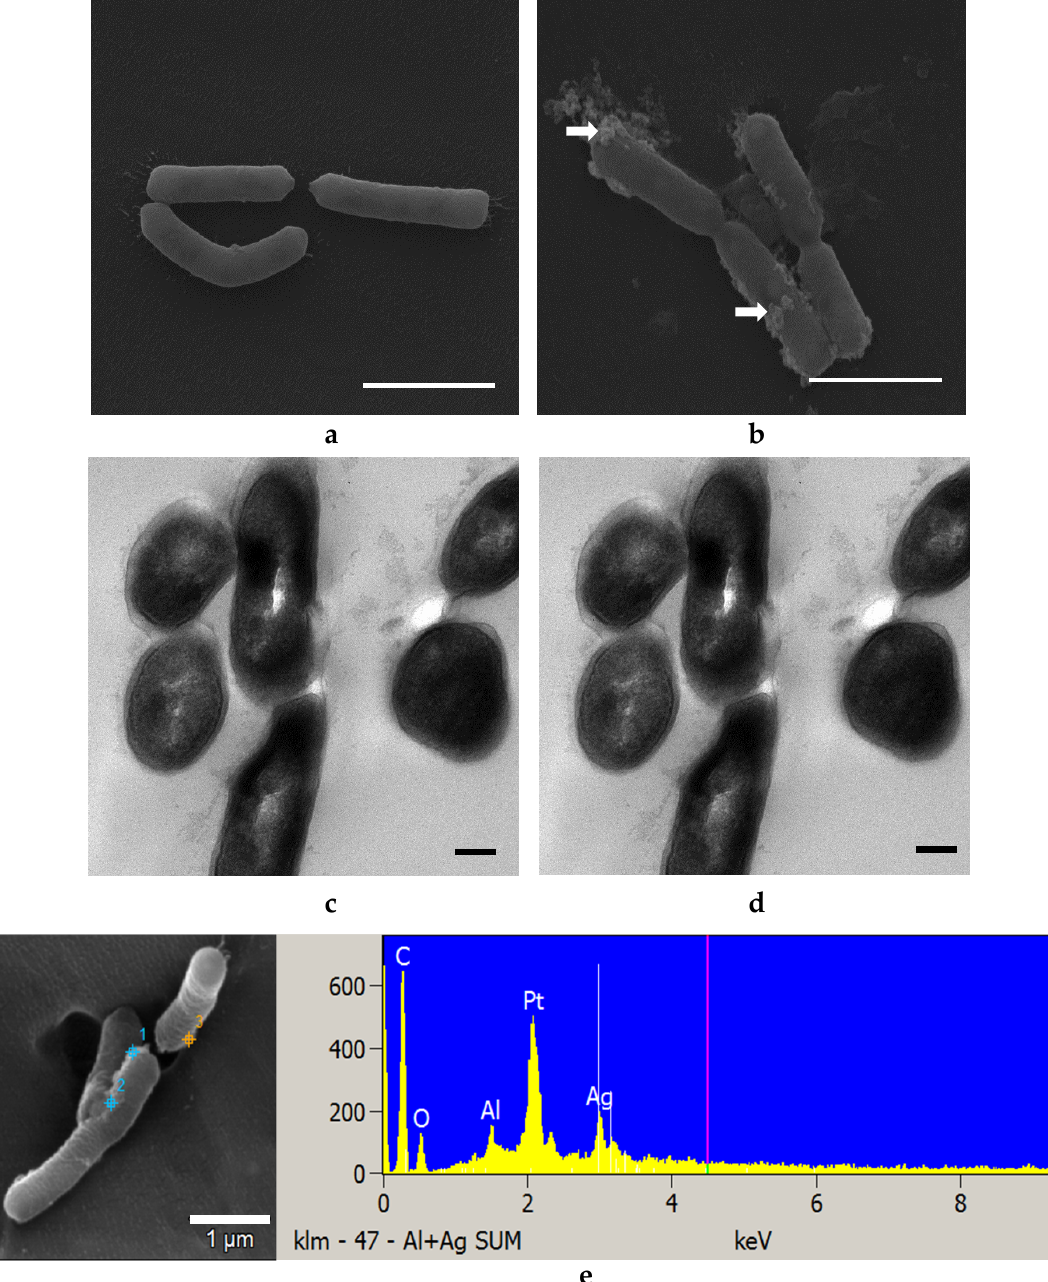
Fig. 9 . SEM (a, b) and TEM (c, d) images of B. animalis untreated with Ag NPs (a, c) and treated with 4.6 mM Ag NPs (b, Figure 9. SEM ( a , b ) and TEM ( c , d ) images of B. animalis untreated with Ag NPs ( a , c ) and treated with 4.6 mM Ag NPs d). SEM-EDS analysis shows Ag NP presence on cell surfaces (e). White arrows indicate clusters of Ag NPs. SEM scale ( b , d ). SEM-EDS analysis shows Ag NP presence on cell surfaces ( e ). White arrows indicate clusters of Ag NPs. SEM scale bar = 2 μ m, TEM scale bar = 0.2 μ m bar = 2 µ m, TEM scale bar = 0.2 µ